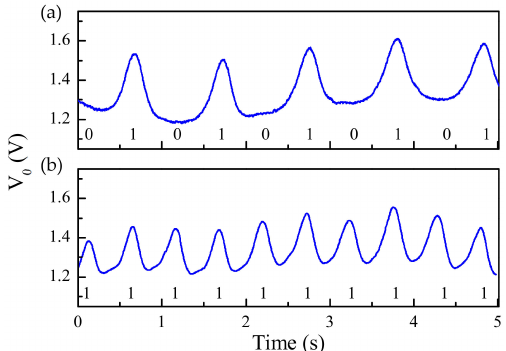
Figure 13. Measured envelope functions corresponding to the 10-bit encoders based on buried di- electric inclusions, with ID codes “1010101010” ( a ) and “1111111111” ( b ). Reprinted with permission from [30]. Copyright 2020